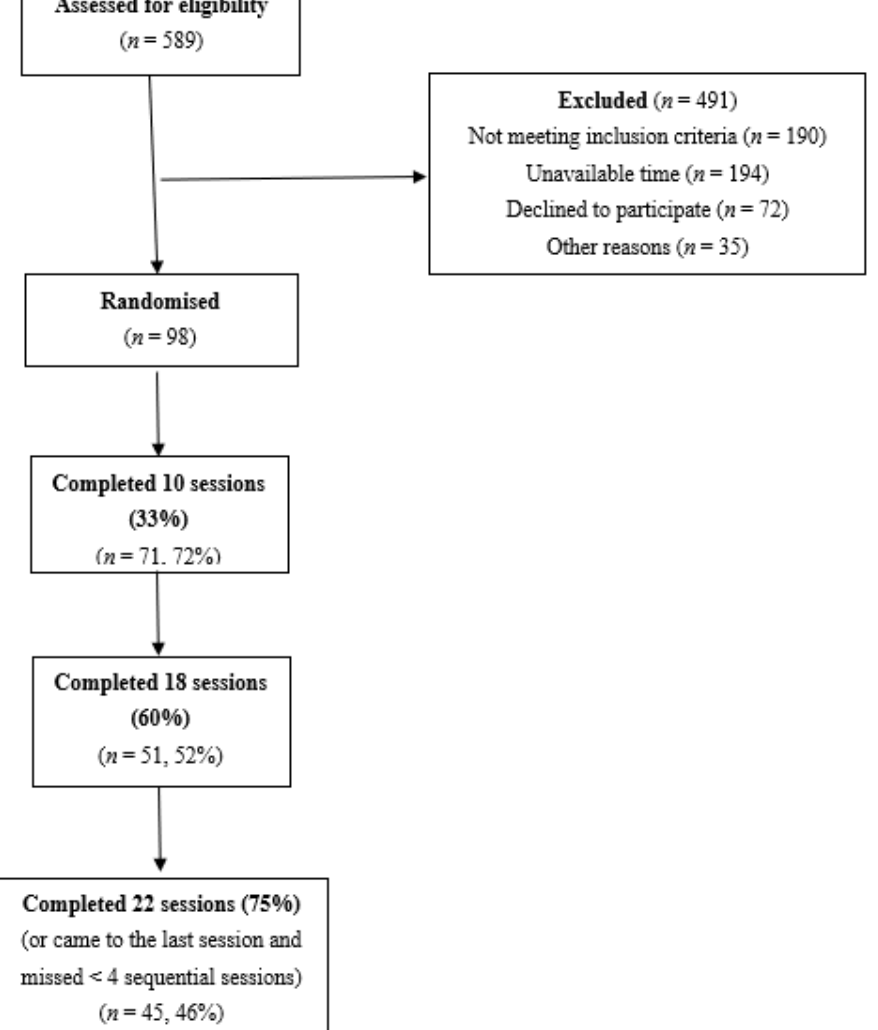
Figure 1. Flow chart diagram.